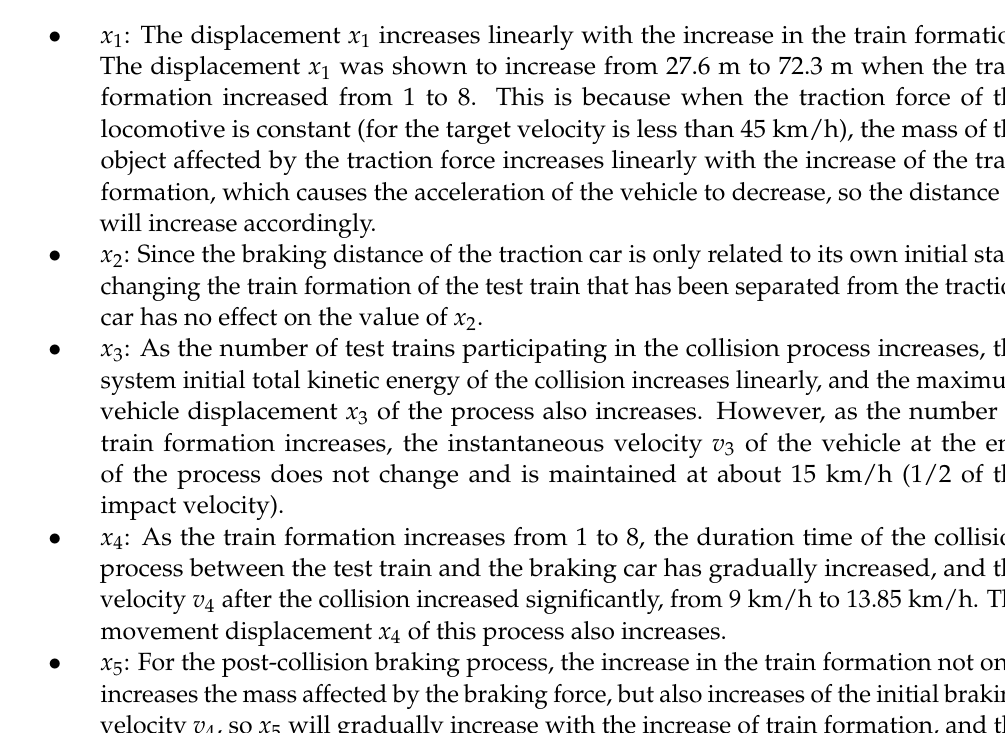
Figure 12. The influence of the train formation on the dynamic response: ( a ) displacement, ( b )